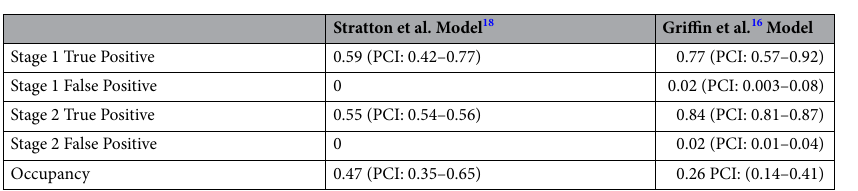
overlap of the credible intervals, the posterior means of the two models do not fall within the intervals for each other, demonstrating the risk of overestimating the probability of occupancy when false positive observation error is ignored. The probability of a true positive observation is estimated as lower for the Stratton et al . 18 model at both Stage 1 and Stage 2 compared to the Griffin et al . 16 model although credible intervals for true positive results at Stage 1 overlap (Table 1).